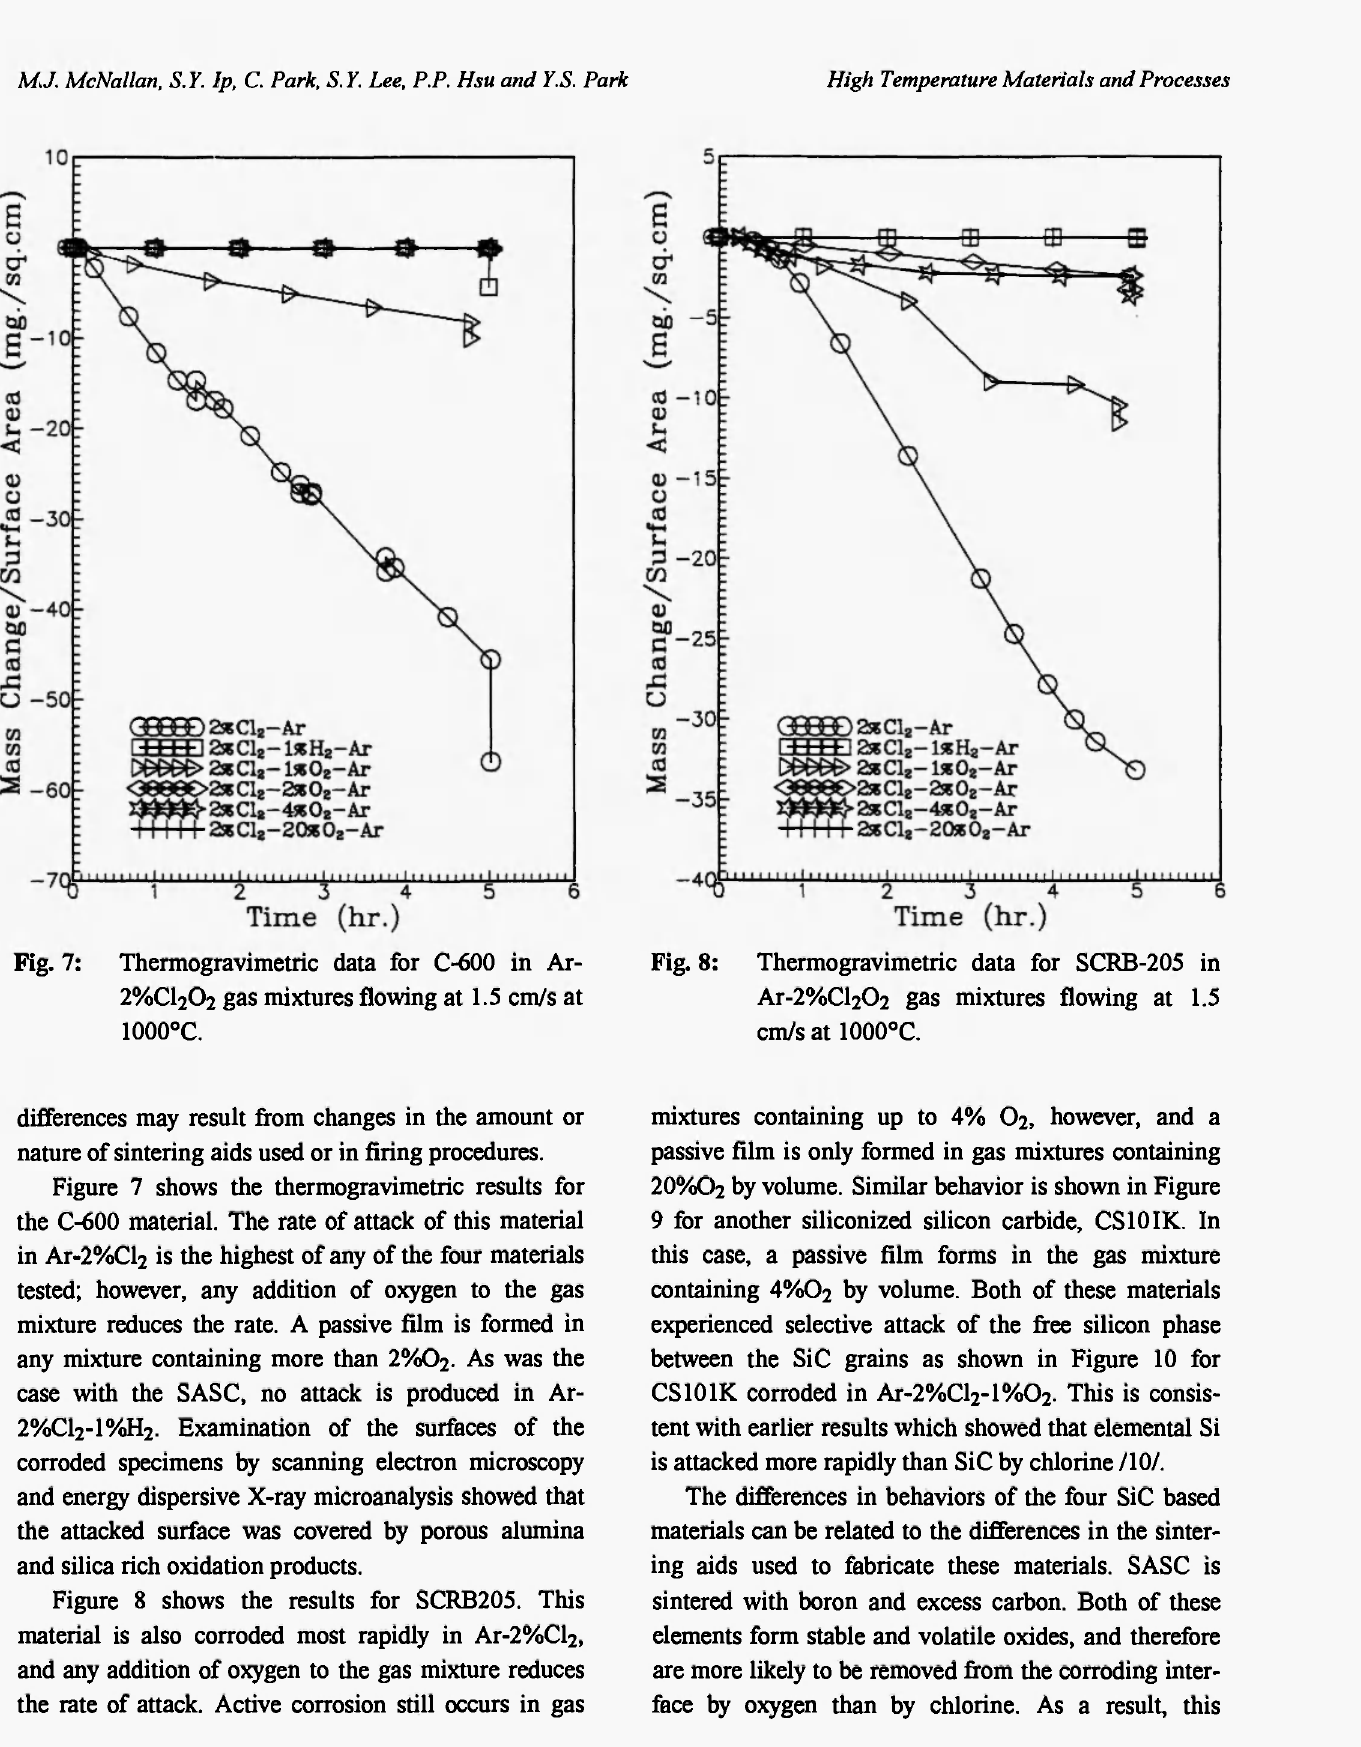
Fig. 8: Thermogravimetric data for SCRB-205 in Ar-2%Cl202 gas mixtures flowing at 1.5 cm/s at mixtures containing up to 4% O2, however, and a passive film is only formed in gas mixtures containing 20%C>2 by volume. Similar behavior is shown in Figure 9 for another siliconized silicon carbide, CS 10IK. In